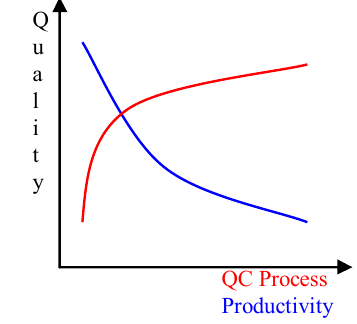
Figure 1. Quality vs QC Process and productivity